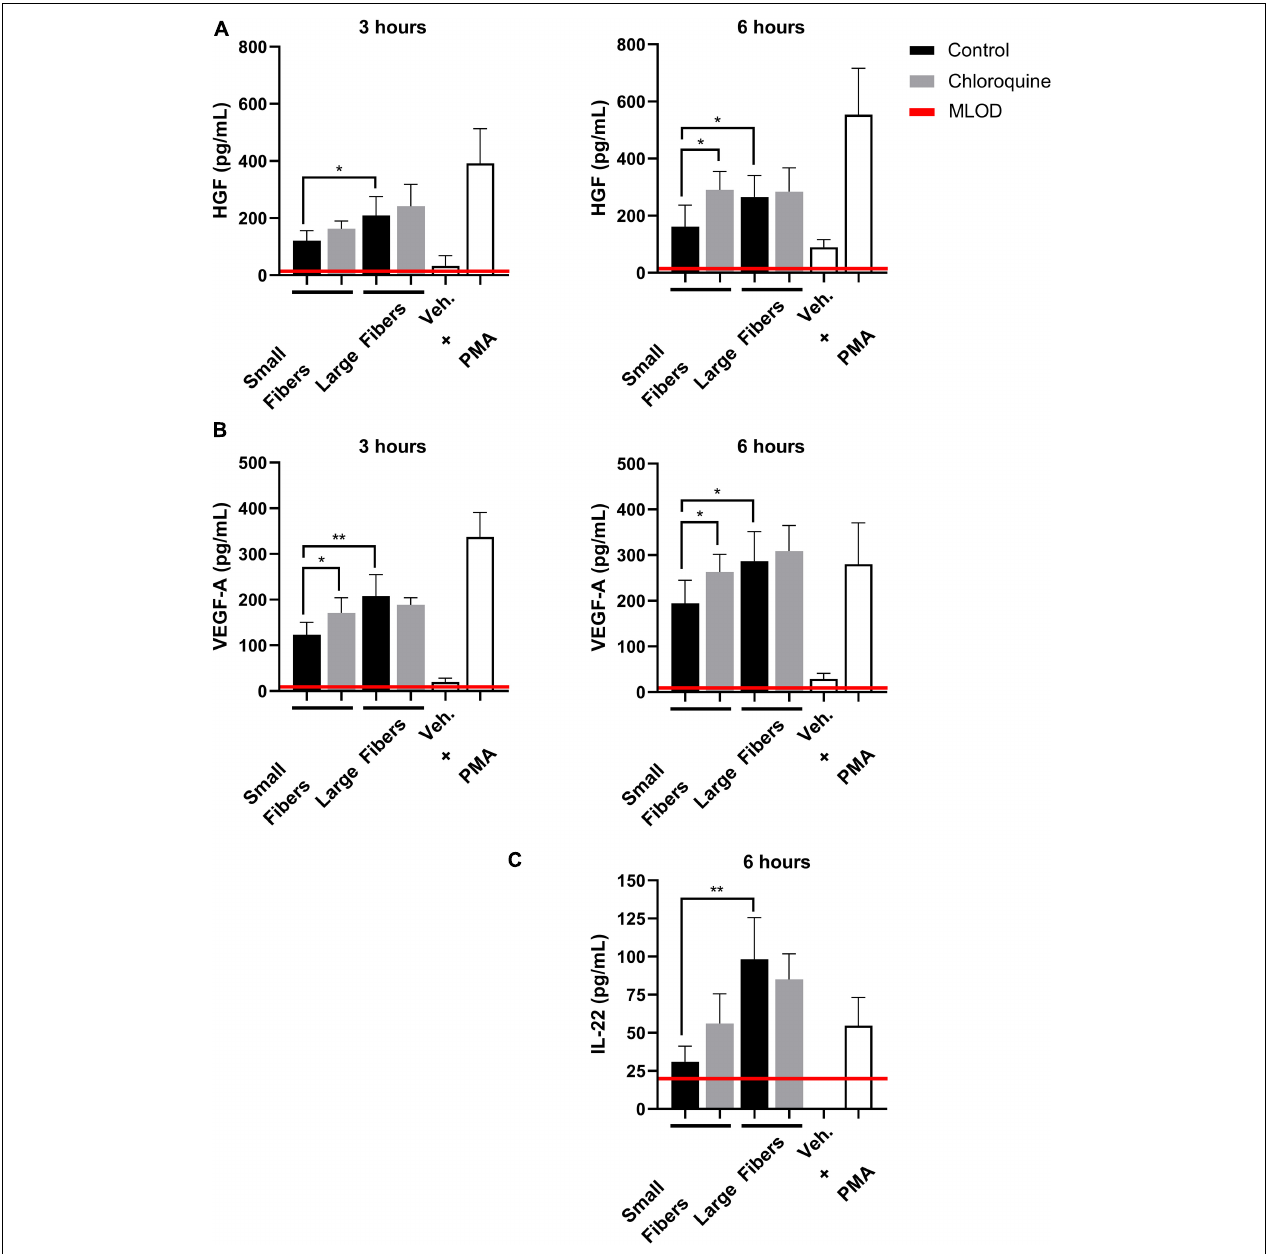
FIGURE 4 | Chloroquine-eluting biomaterials increase regenerative HGF, VEGF-A, and IL-22 secretion from neutrophils. (A) HGF and (B) VEGF-A were up-regulated with chloroquine elution at 3 h (left) and 6 h (right) after seeding, whereas (C) IL-22 was only detectable and up-regulated at 6 h after seeding. The data ( n = 3) represent the mean ± standard deviation of three independent experiments with unique donors. * p < 0.05 and ** p < 0.0001 were determined using an analysis of variance (ANOVA) and Holm–Sidak multiple-comparisons test. Raw data are available in Supplementary Spreadsheet 1